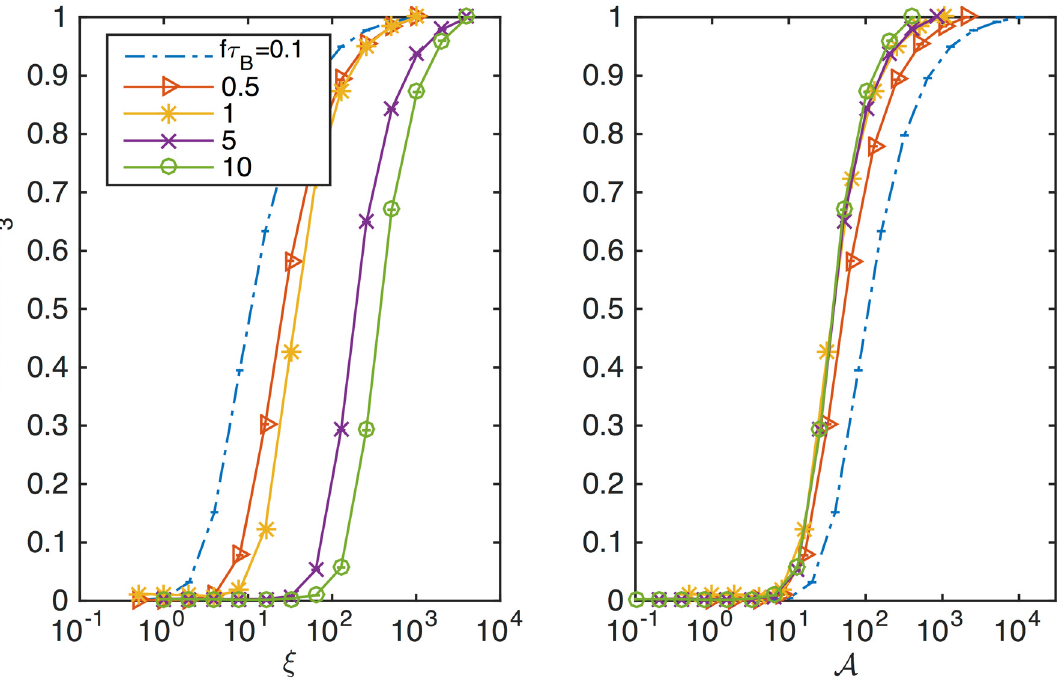
Fig 2. (Color online) The scaling relationship in the magnetization harmonics is simulated by varying the mean unitless field. The normalized third harmonic plotted against the mean magnetic field amplitudes in the left panel, and against the master variable on the right. The plots illustrate that spectra from nanoparticles with different relaxation times (when h Ω i > 1) will align when plotted against their respective master